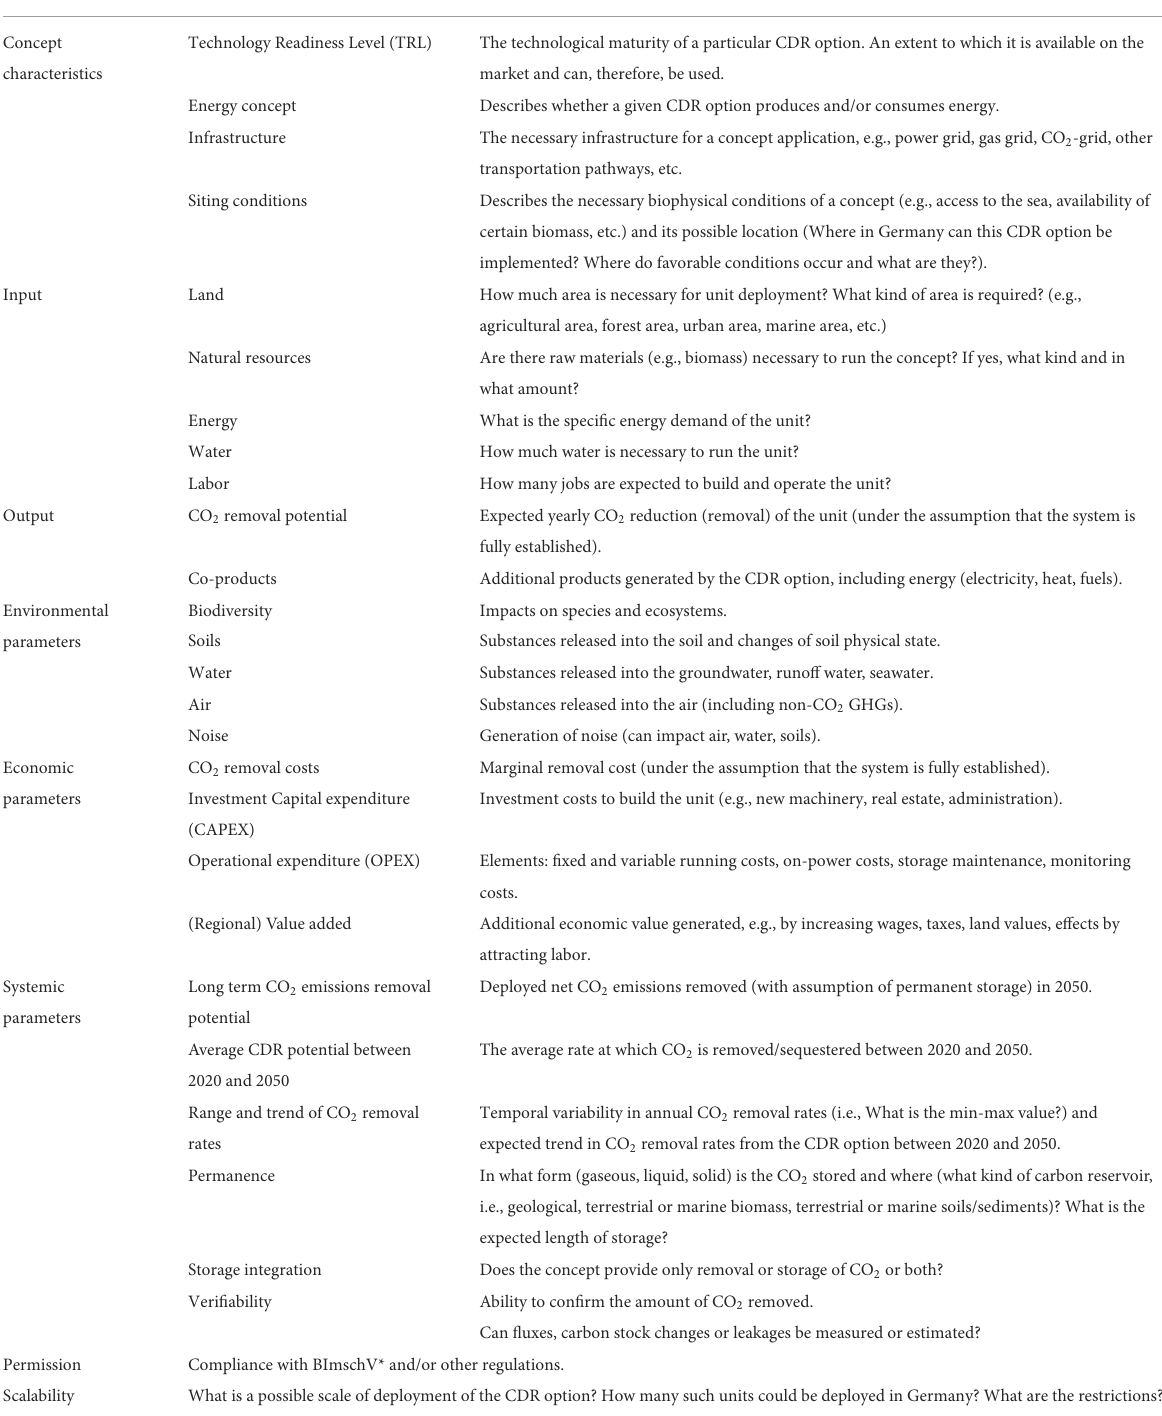
TABLE 1 Fact sheet design and description of individual